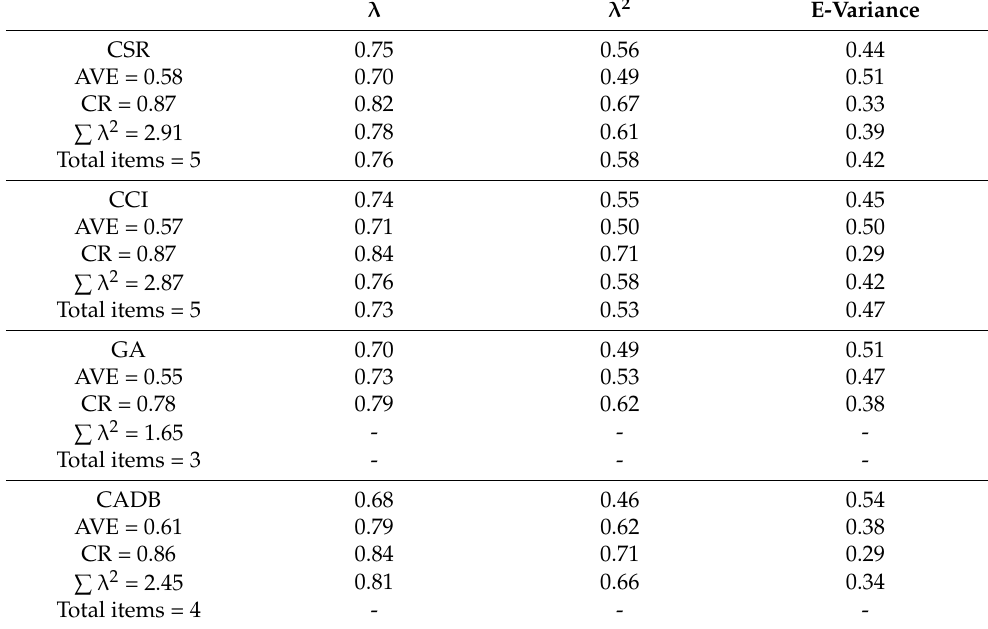
Table 4. Summary of initial